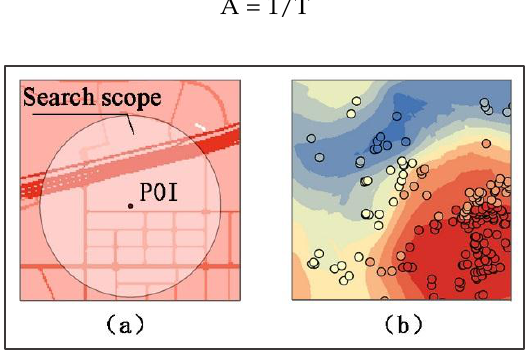
Figure 4. Methods and Procedures 2: ( a ) FCA; ( b ) Hot Spot Analysis.